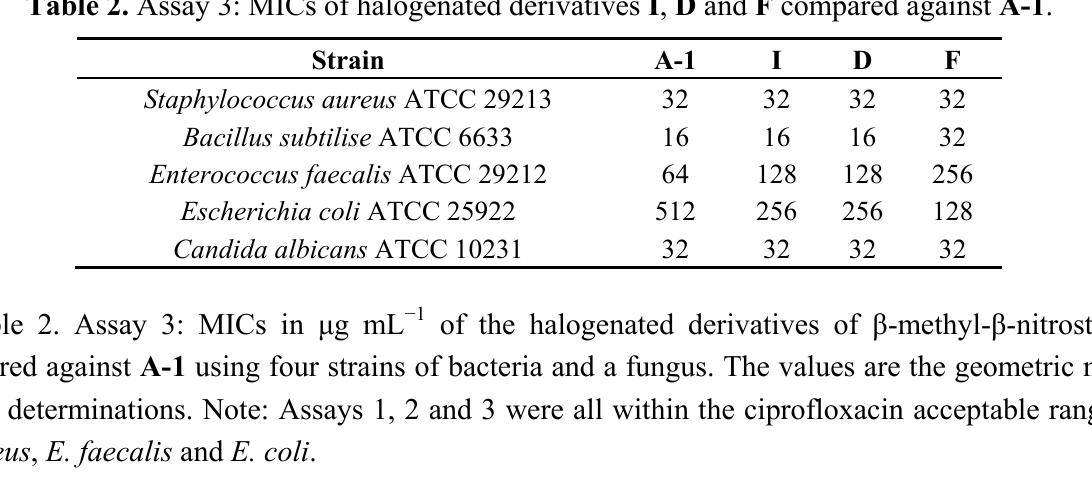
Table 2. Assay 3: MICs of halogenated derivatives I , D and F compared against A-1 .